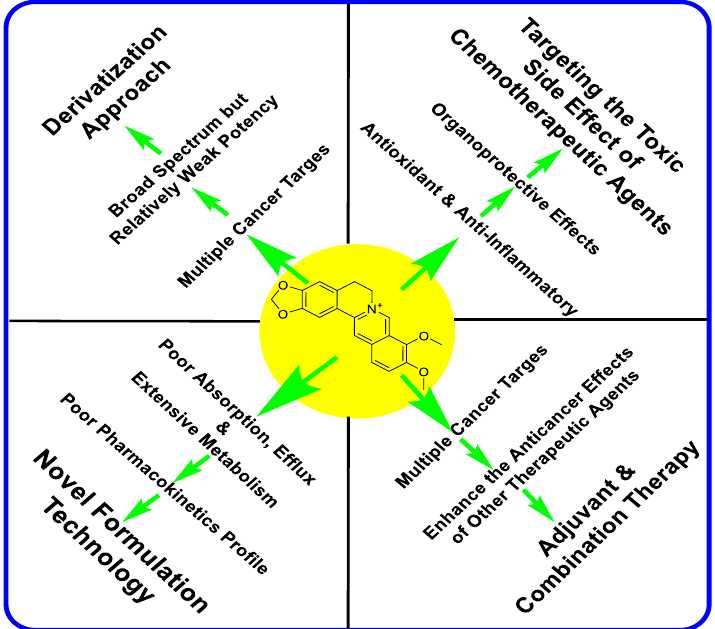
Figure 13. Research approaches over the last two decades that focus on improving the anticancer potential of berberine.